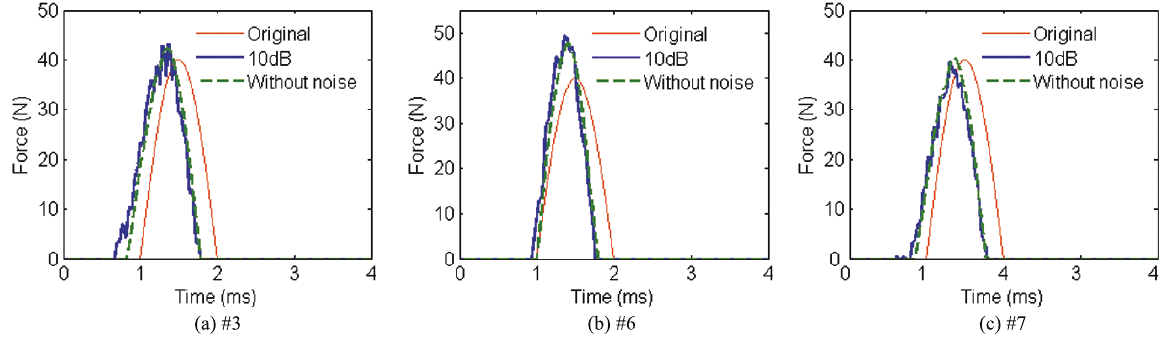
Fig. 9. Impact force time-history reconstructions with Gauss distribution